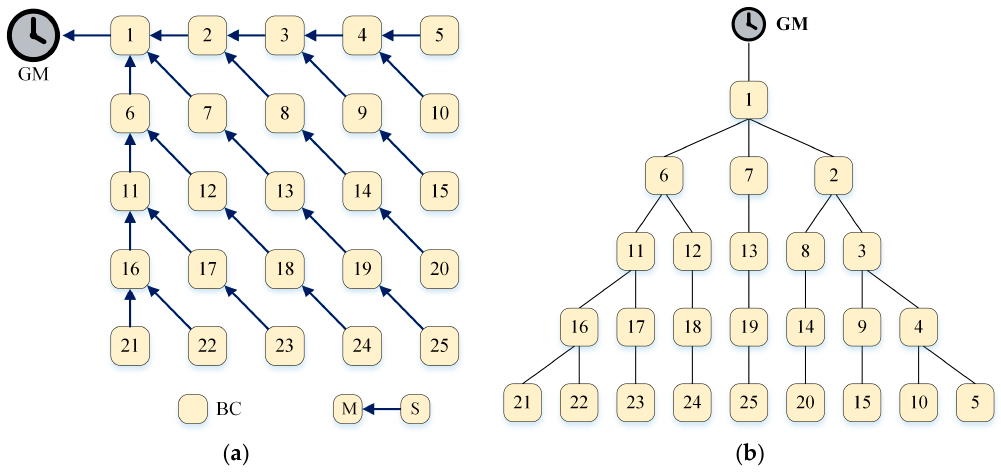
Figure 7. The master-slave hierarchy established by the BSHSM algorithm. ( a ) Master-slave hierarchy; and ( b ) synchronization tree.